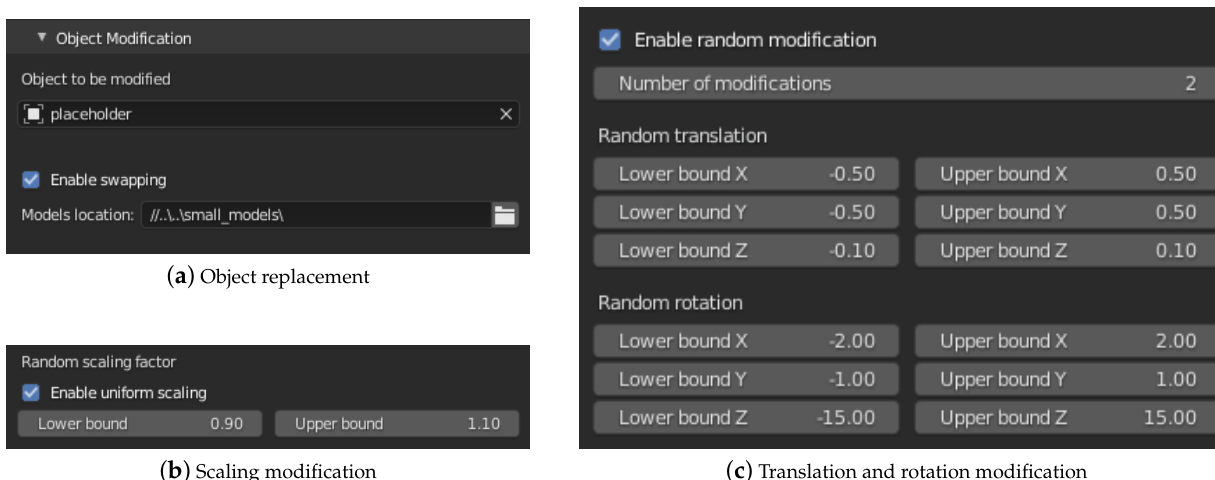
Figure 5. The shown menu allows the automated adjustment of a scene. The object to be modified can be exchanged (swap) with predefined models. In addition, the random modification of the property translation, rotation and scaling is